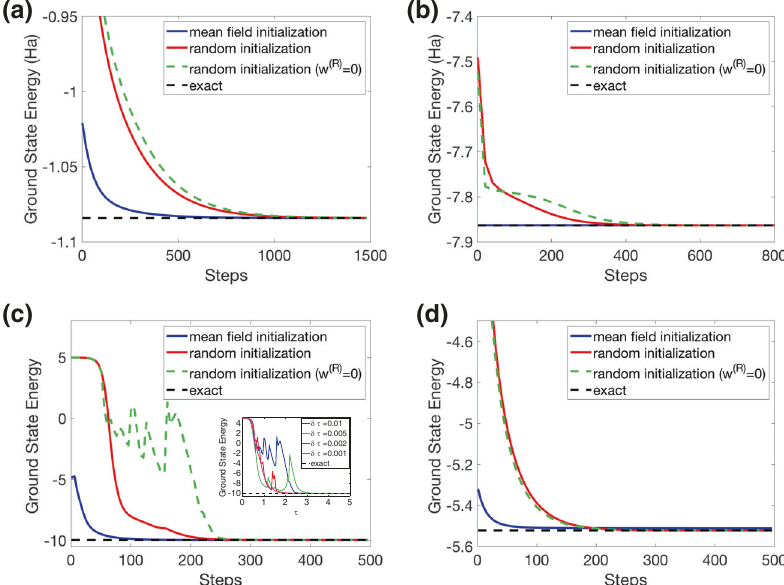
Fig. 5 Imaginary-time evolution with RBM states. Simulations of the ground state energy using NQS-ITE with random initialization (solid red lines), mean- fi eld initialization (solid blue lines), and random initialization for the unitary-coupled RBM ansatz (dashed green lines). The dashed black lines show the ground state energy from exact diagonalization. Results for a H 2 at equilibrium bond length (1.05 Å ), b LiH at equilibrium bond length (1.5 Å ), c Heisenberg chain ( N = 6, h = 0), and d Ising chain ( N = 6, h = 0.5). The inset in c displays the results for the unitary- coupled RBM ansatz using different time-step sizes, δτ , where τ = steps* δτ